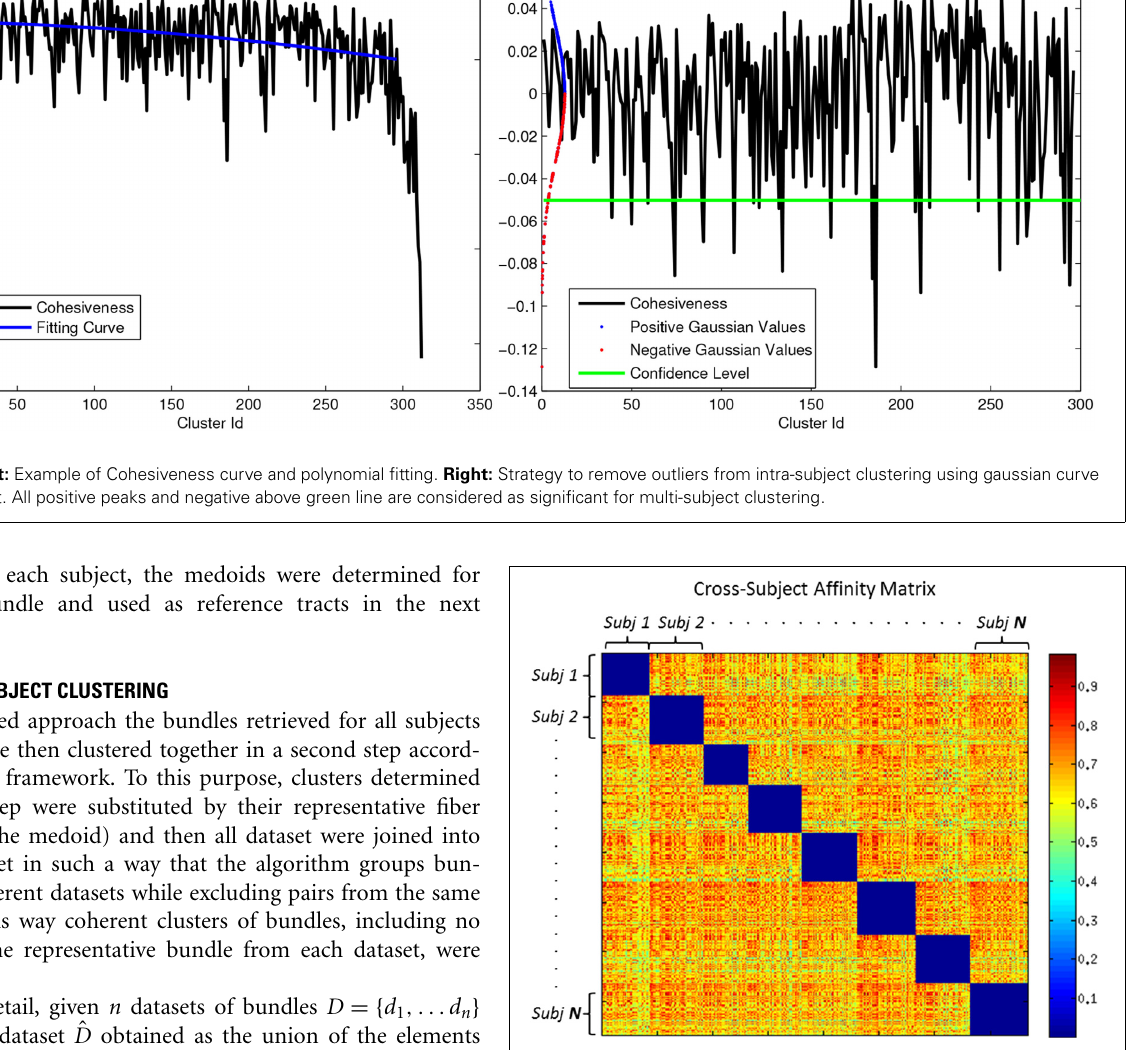
FIGURE 4 | Cross Subject Adjacency Matrix: each non-zero block represents the similarity between centroids across different